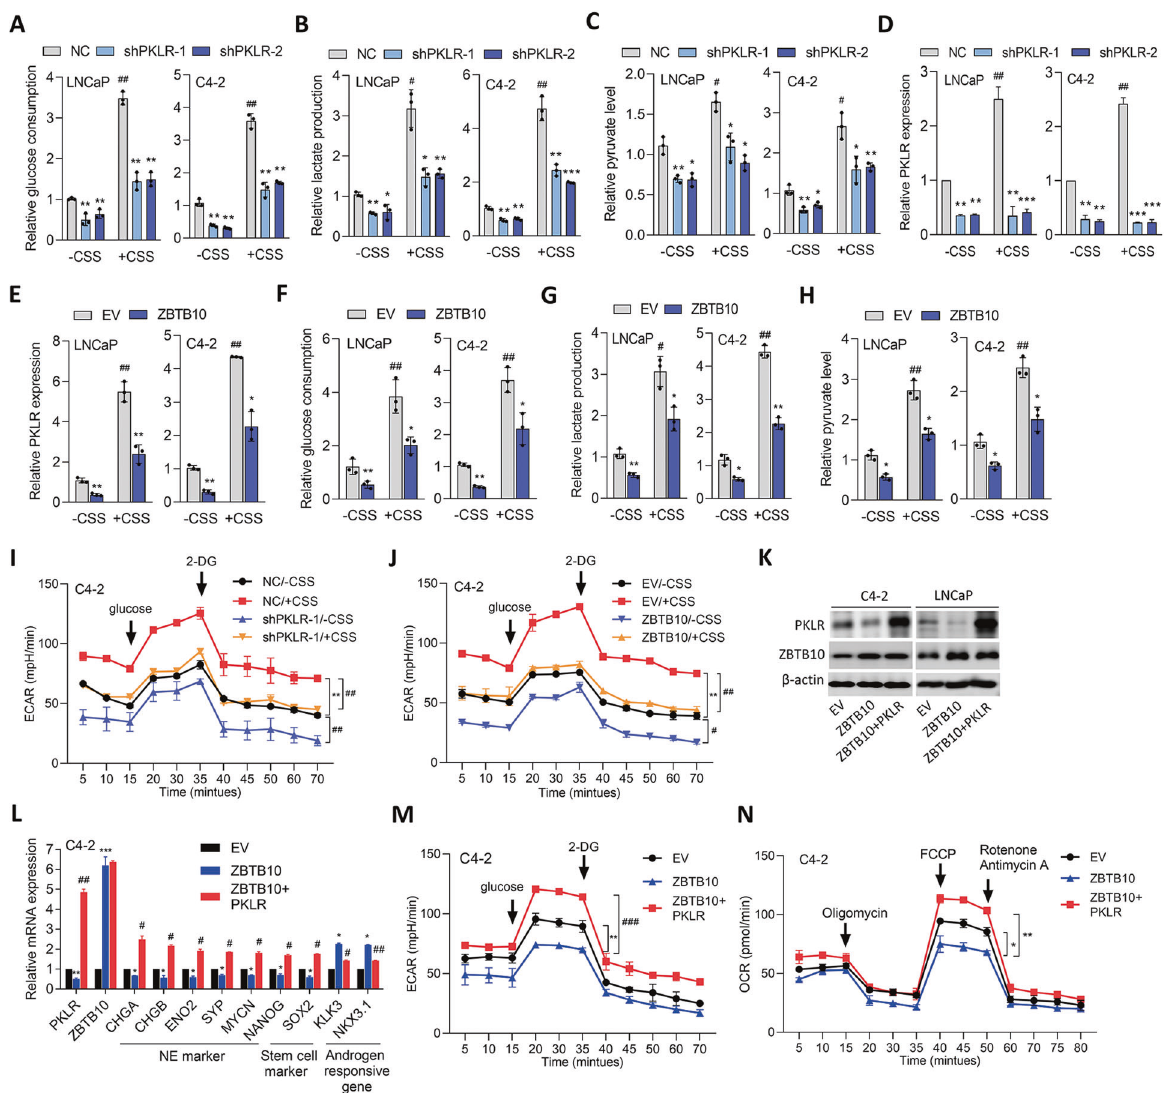
Fig. 4 PKLR rescues ZBTB10-decreased glucose metabolism. A – C Quanti fi cation of glucose uptake ( A ), lactate amounts ( B ), and pyruvate levels ( C ) by colorimetric assays of LNCaP and C4-2 cells expressing the non-target control (NC) or PKLR shRNA vector and incubated with charcoal-stripped serum (CSS)-containing medium for 48 h. n = 3 per group. * vs. the NC; # vs. -CSS; by a two-way ANOVA. D Relative PKLR mRNA levels in LNCaP and C4-2 cells stably expressing the NC or PKLR shRNA vector. n = 3 per group. * vs. the NC; # vs. -CSS. ** p < 0.01, *** p < 0.001; by a two-way ANOVA. E-G Quanti fi cation of glucose uptake ( E ), lactate amounts ( F ), and pyruvate levels ( G ) by colorimetric assays of LNCaP and C4-2 cells expressing the empty vector (EV) or ZBTB10 cDNA vector and incubated with CSS-containing medium for 48 h. n = 3 per group. * vs. the EV; # vs. -CSS; by a two-way ANOVA. Relative glucose uptake, lactate amounts, and pyruvate levels are presented as the mean ± SEM from three biological replicates. * p < 0.05, ** p < 0.01, *** p < 0.001. H Relative PKLR mRNA levels in LNCaP and C4-2 cells stably expressing the EV or ZBTB10 cDNA vector. n = 3 per group. * vs. the EV; # vs. -CSS. * p < 0.05, ** p < 0.01; by a two-way ANOVA. I , J Bioenergetics trace from the Seahorse analysis showing values of the extracellular acidi fi cation rate (ECAR) in C4-2 cells with expression of the NC or PKLR shRNA vector ( I ) and EV or ZBTB10 cDNA vector ( J ) following treatment with CSS-containing medium for 48 h, and incubated with 12 mM D - glucose and 50 mM 2-deoxyglucose (2-DG). * vs. -CSS; # vs. the NC ( I ) or EV ( J ); by a two-way ANOVA. K PKLR and ZBTB10 protein levels of C4-2 and LNCaP cells stably express the EV, ZBTB10, or ZBTB10 + PKLR cDNA vector. L Relative PKLR, ZBTB10, NE marker, stem cell marker, and androgen-responsive gene mRNA levels in C4-2 cells expressing the EV, ZBTB10, or ZBTB10 + PKLR cDNA vector. * vs. the EV; # vs. ZBTB10; by a two-way ANOVA. Quanti fi cation of mRNA is presented as the mean ± SEM from three biological replicates. * p < 0.05, ** p < 0.01, *** p < 0.001. M Bioenergetics trace from the Seahorse analysis showing ECAR values in C4-2 cells with ex p ression of the EV, ZBTB10, or ZBTB10 + PKLR cDNA vector, and incubated with 12 mM D -glucose and 50 mM 2-DG. N Bioenergetics trace from the Seahorse analysis showing oxygen consumption rate (OCR) values in C4-2 cells with stable EV, PKLR, or PKLR + ZBTB10 cDNA vector expression, and incubated with 1 μ M oligomycin, 0.75 μ M FCCP, and 0.5 μ M each of rotenone and antimycin A. * vs. the EV; # vs. ZBTB10; by a two-way ANOVA. Relative ECAR and OCR values are presented as the mean ± SEM from three biological replicates. * p < 0.05, ** p < 0.01, *** p < 0.001. signi fi cantly higher cell migration and invasion (Fig. 5I, J). migration and invasion of ZBTB10-expressing cells compared to Decreased levels of proliferation markers ( MKI67 and PCNA ) and PKLR-rescued ZBTB10-expressing cells, and found that cells epithelial-mesenchymal transition (EMT) markers ( SNAI1, TWIST1 , expressing ZBTB10 showed reduced cell migration and invasion; and VIM ) were found in ZBTB10-overexpressing cells; whereas however, ZBTB10-expressing cells rescued with PKLR exhibited Cell Death and Disease (2022)